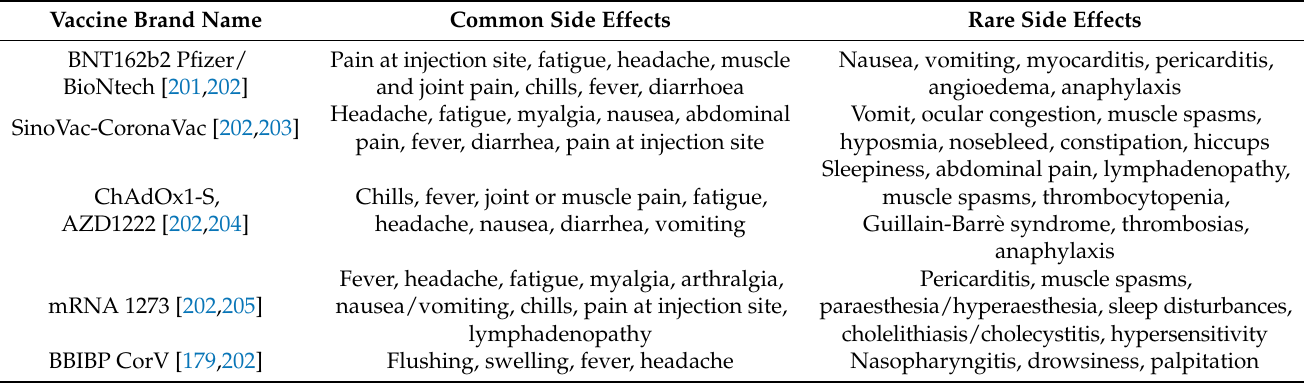
Table 2. Main side effects of vaccines for